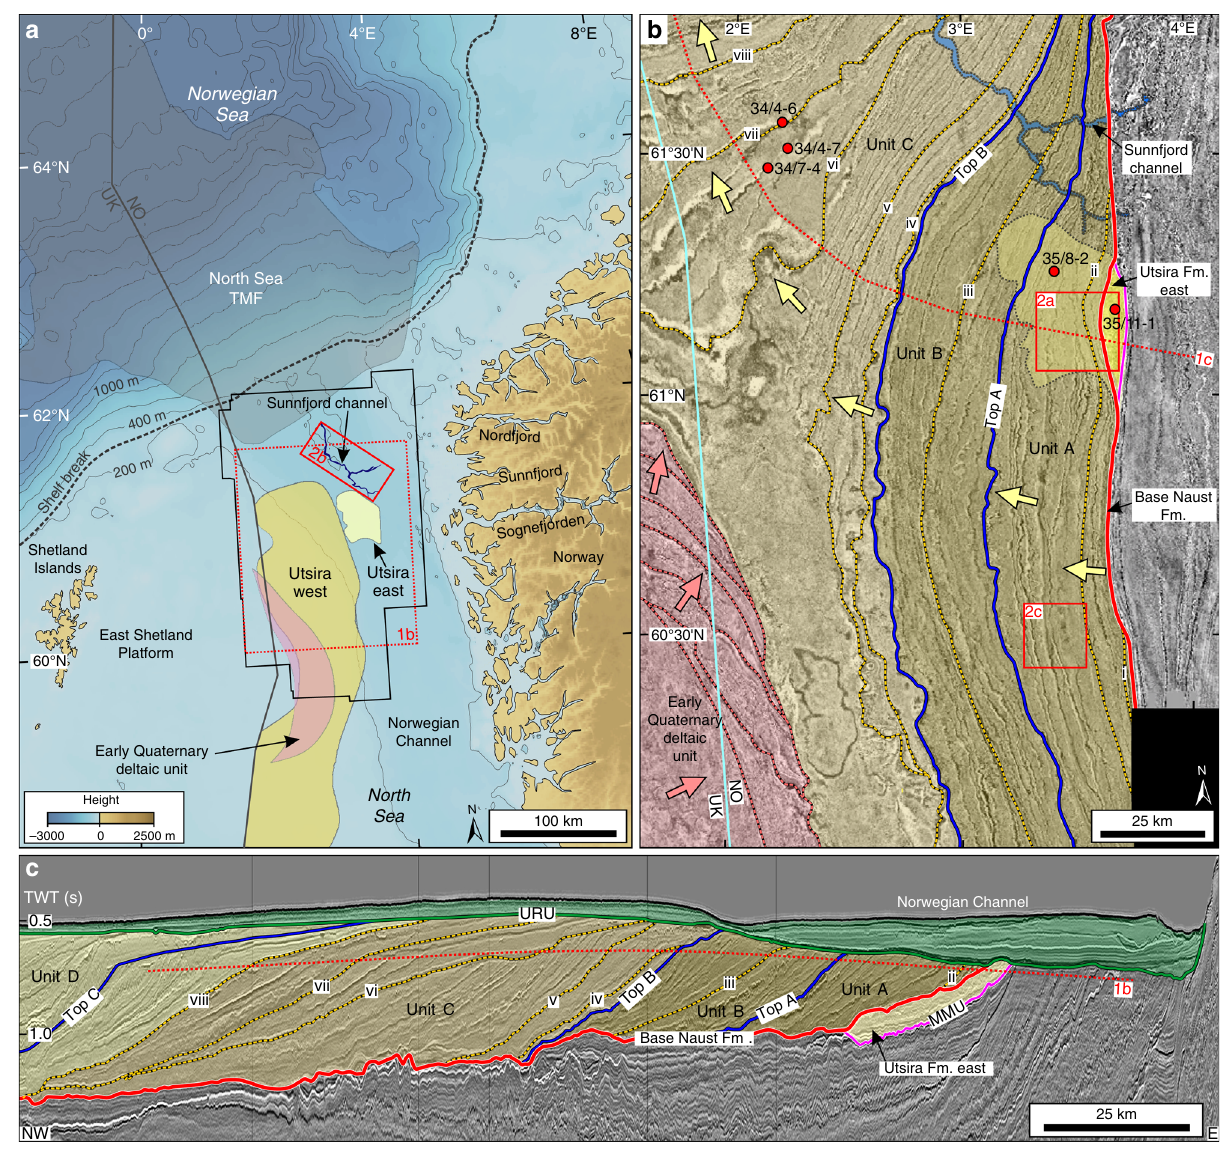
Fig. 1 Location and seismic data. a Location map of the northern North Sea margin, showing the position of the 3D time-migrated CGGNVG broadband (BroadSeis) seismic cube (solid black outline). Black dashed line is present-day shelf break. Grey fi ll is main depocentre of the North Sea trough-mouth fan (TMF) from Nygård et al. 29 . The distribution of the western Utsira Formation sands is from Eidvin et al. 31 . b Amplitude map showing the Pliocene to Quaternary in fi ll of the northern North Sea Basin (location in Fig. 1a). The amplitudes are extracted from an arbitrary surface that cuts prograding clinoforms (dashed red line in Fig. 1c). Brown fi lled area is glacigenic debris- fl ows that prograded to the west and northwest from the Norwegian mainland. Some of the clinoforms are labelled (i – viii, from oldest to youngest), and the adjusted tops of units A to C of Ottesen et al. 13,14 and Batchelor et al. 20 are shown. Regional ties and estimates suggest the following ages: top Unit A ~2.2 – 2.0 M yr, top Unit B ~1.7 – 1.6 M yr, clinoform (v) ~1.5 M yr, and clinoform (vi) ~1.2 M yr (Methods; Supplementary Fig. 1). Pink fi ll is an early Quaternary deltaic unit that prograded to the northeast from the East Shetland Platform 14 . Yellow fi ll is the Utsira Formation east (of probable Pliocene age), which was deposited prior to the glacigenic debris- fl ows. Red circles are wells. c Seismic pro fi le showing the Pliocene to Quaternary in fi ll of the northern North Sea Basin (location in Fig. 1b). The top of Unit C is the base of the North Sea TMF. Green fi ll shows fl at-lying units above the Upper Regional Unconformity (URU) in the Norwegian Channel. Colours and labels are the same as in Fig. 1b. Mid Miocene Unconformity Full ice-sheet glaciation – Naust Formation . We mapped details The positions of one clinoform-intersection appear as a of the prograding shelf clinoforms of the Quaternary Naust continuous re fl ection-line in Fig. 1b, showing the location of Formation for the entire northern North Sea from 3D seismic that clinoform at this time. The detailed positions of all the Naust data. This was performed by extracting amplitude values along a Formation clinoforms in this map describe the early Quaternary detailed constructed surface that intersects the prograding sediment in fi ll of the northern North Sea, like growth rings in clinoforms (Fig. 1c). In the eastern North Sea Basin, the upper trees (we count 47), from the oldest clinoform (i) in the east to the parts of the Naust Formation clinoforms are eroded by the URU youngest (viii) in the northwest. The east and northeastward and this surface cuts gradually deeper into the eastern Utsira migrations of the East Shetland Platform clinoforms are also Formation, the MMU, older units and fi nally into basement. shown in Fig. 1b. The eastward and westward prograding